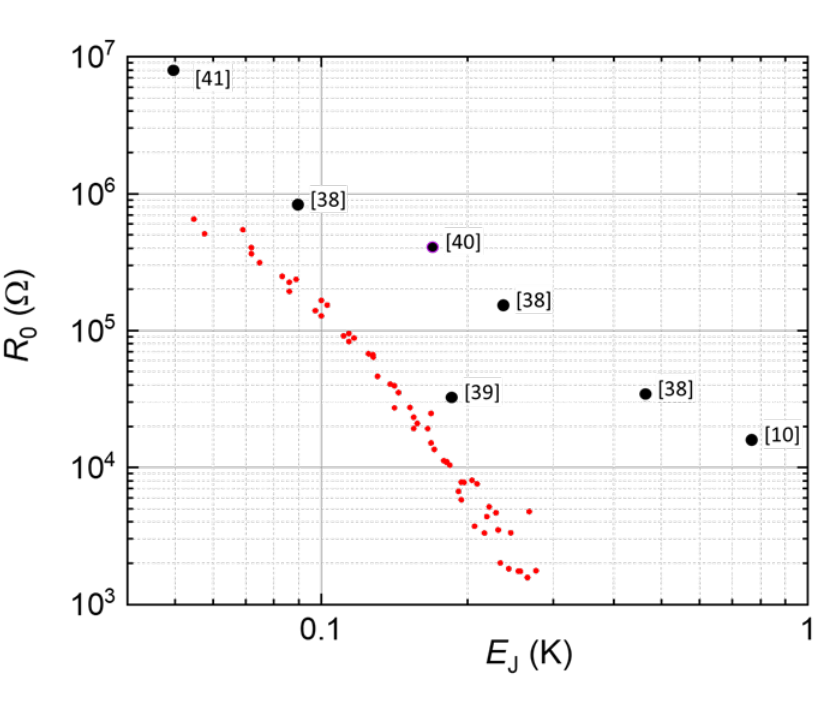
Figure 6. The zero-bias resistance R 0 as a function of E J measured for a chain of SQUIDs made of JJs with E J = 0.43 K (sample 5 in Table 1) (red dots). For comparison, the values of R 0 measured by other experimental groups for Al / AlO X / Al junctions (black dots, the references are given in square brackets) are also plotted, the parameters of these samples are listed in Table 2. All the data have been obtained at the base T < 50 mK, though the physical temperature of the Josephson circuits has not been directly measured. The Josephson energy E J ( B ) for sample 5 was calculated using Equation